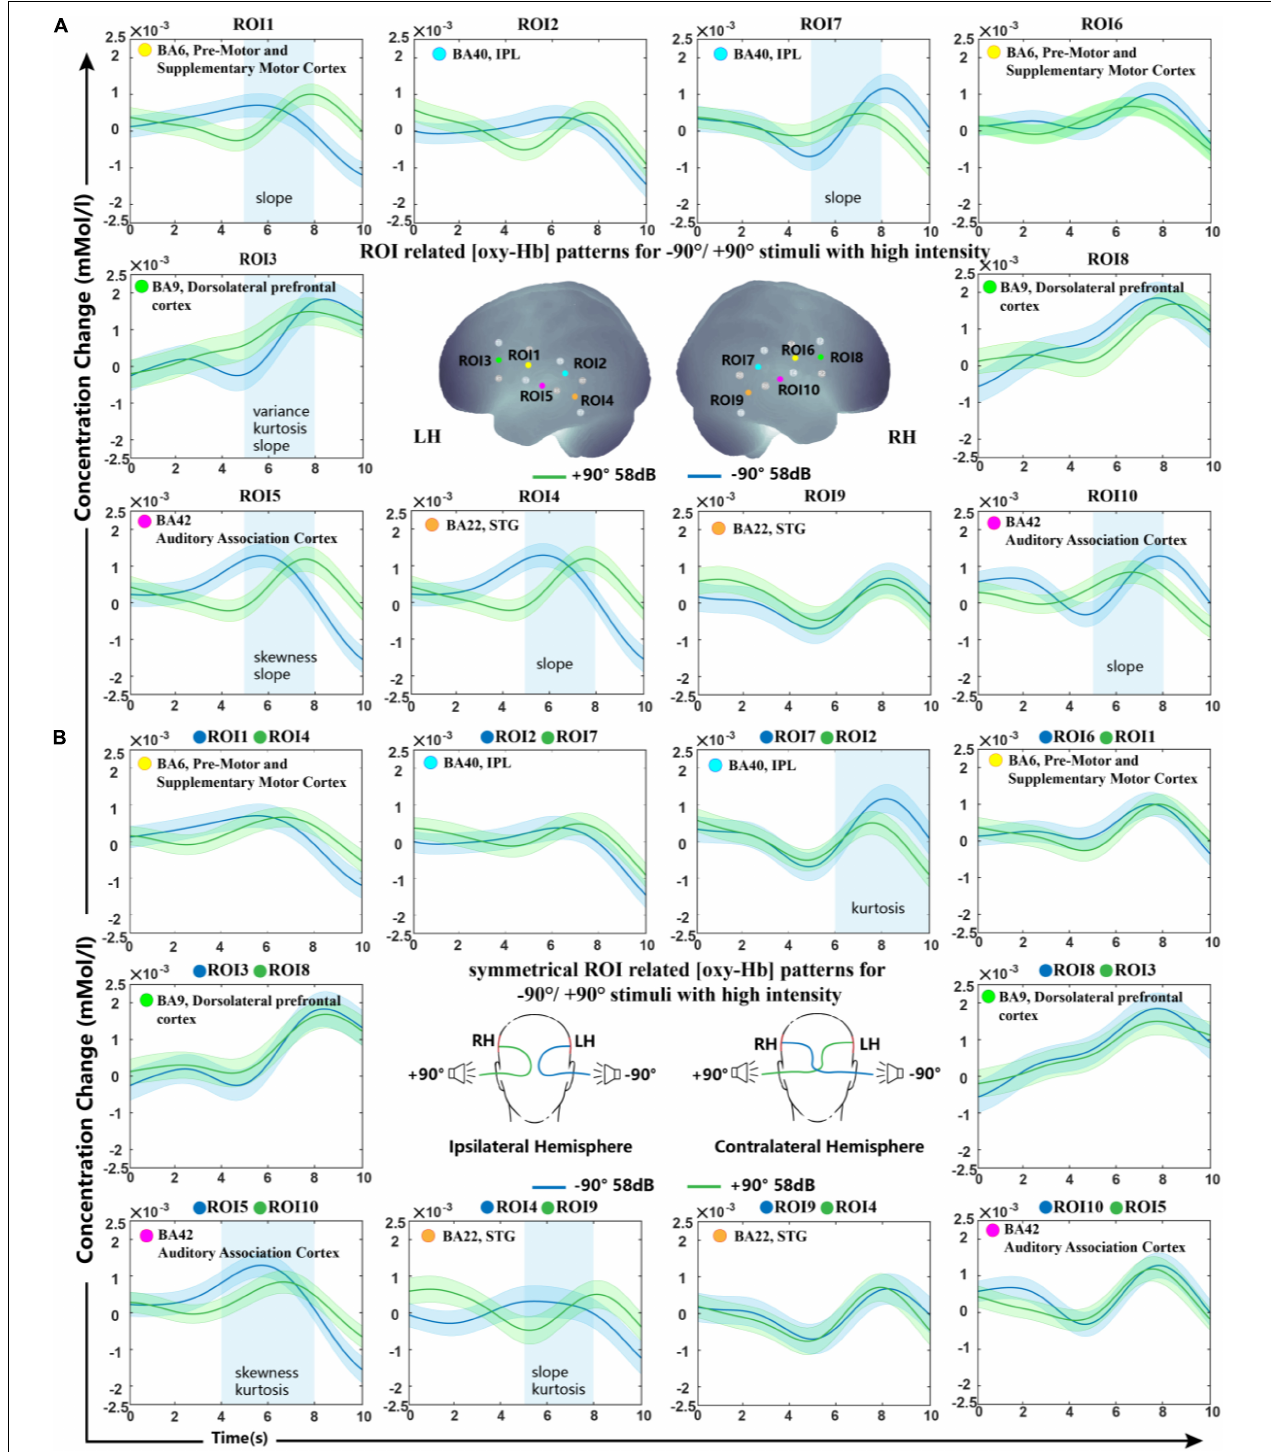
FIGURE 3 | Grand-average oxy-Hb response recorded for –90 ◦ and +90 ◦ sound sources for all ROIs. (A) ROIs in the right and left hemisphere. (B) Ipsilateral and contralateral ROI signals of the two conditions. The blue squares on the panel represent time periods in which significant differences in oxy-Hb responses between signals of symmetrical hemisphere ROIs take place. The shaded regions indicate the standard errors computed across all subjects for the relative condition.